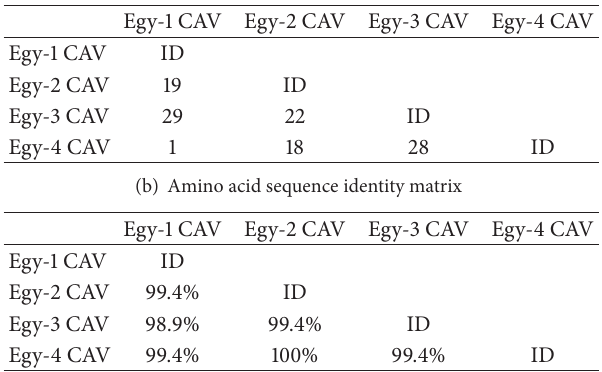
Table 2: Nucleotide and deduced amino acid difference and identity matrices among Egyptian CAV